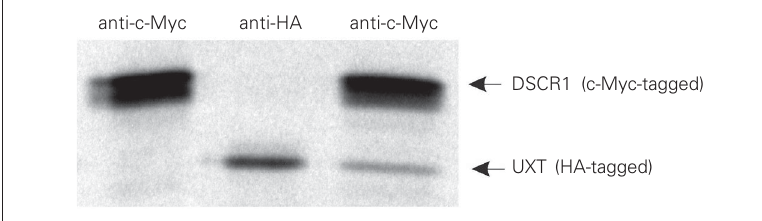
Figure 2. Gel electrophoresis showing that Down’s syndrome candidate region 1 (DSCR1) co-immunoprecipitates with a ubiquitously expressed transcript (UXT) protein. cDNAs encoding c-Myc-DSCR1 and hemagglutinin (HA)-UXT were translated and simultaneously labeled with [ 35 S]-methionine in vitro using rabbit reticulocyte lysates. They were assessed for their ability to interact and visualized by autoradiography. The c-Myc-DSCR1 and HA- UXT proteins were immunoprecipitated using an anti-c-Myc